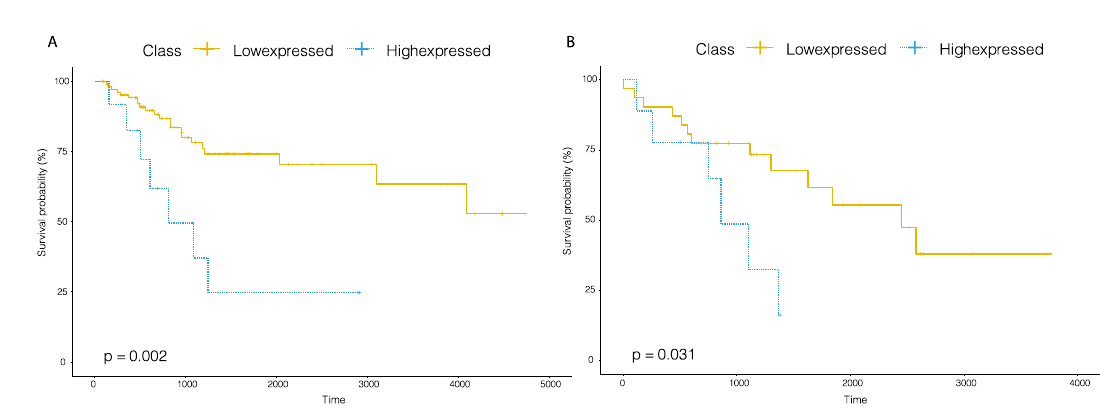
Figure 3. Kaplan–Meier curves of overall survival for patients treated with cisplatin or gemcitabine at low or high expressed classes stratified by miR-296 in the CESE or SARC.